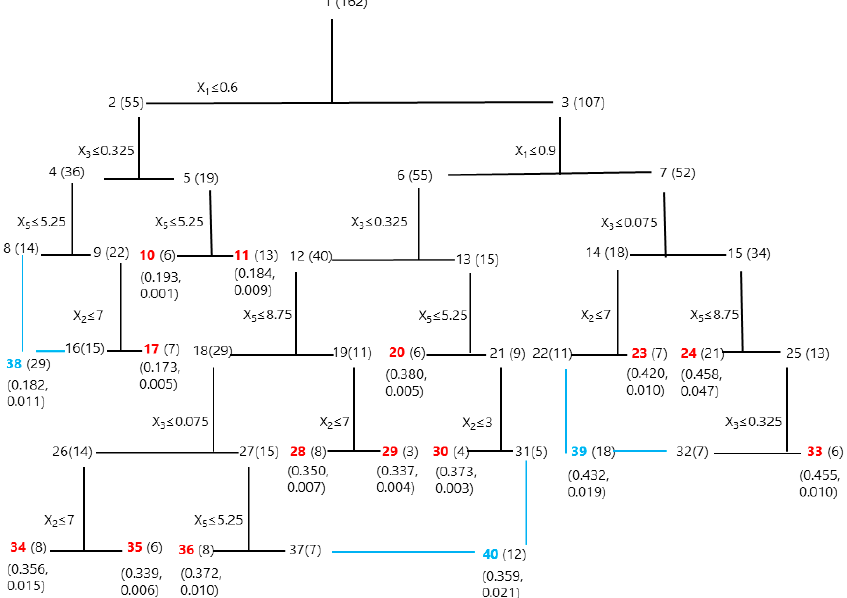
Figure 2. The stepwise-cluster analysis (SCA) tree for phenanthrene immobilization at aqueous/modified palygorskite interface (Run No. 3, the cutting nodes are highlighted in red while the merging nodes are highlighted in blue). X 1 : Initial phenanthrene concentration; X 2 : Added HA dose; X 3 : Ionic strength; X 4 : Temperature; X 5 : pH.